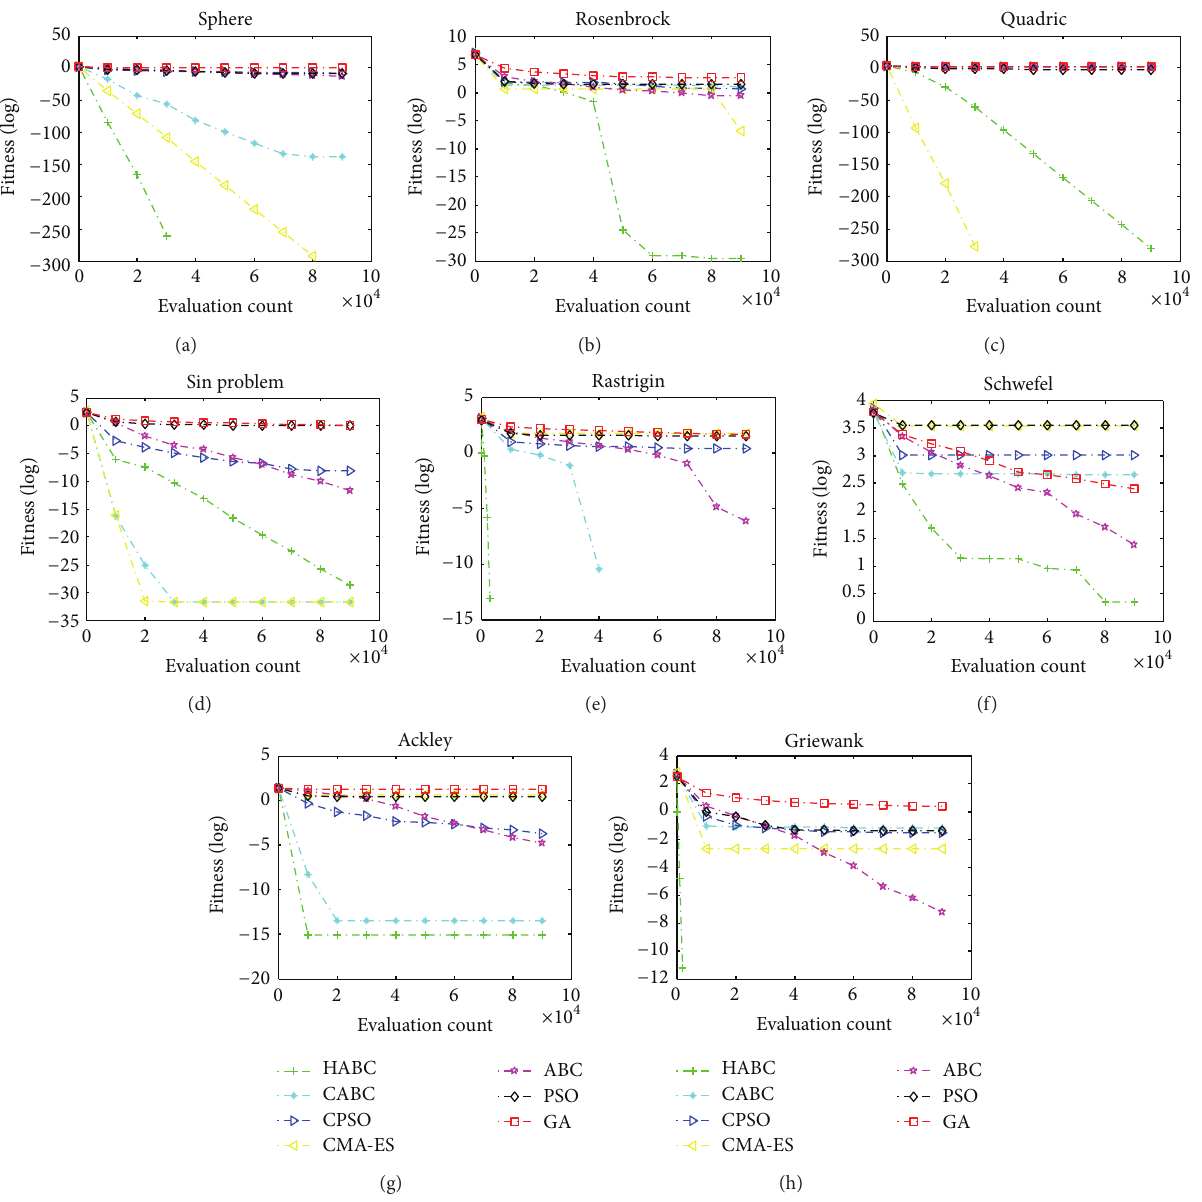
Figure 4: The median convergence results of 50D continuous functions. (a) Sphere. (b) Rosenbrock. (c) Quadric. (d) Sin problem. (e) Rastrigin. (f) Schwefel function. (g) Ackley. (h)